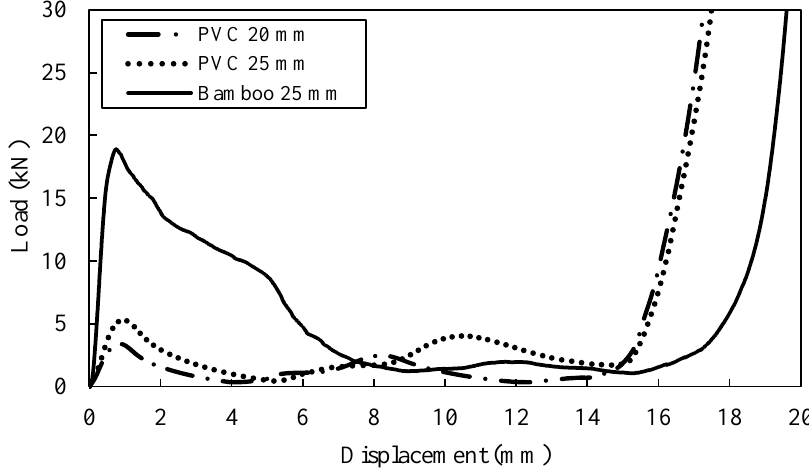
Figure 4. Load-displacement curves for three types of tube.